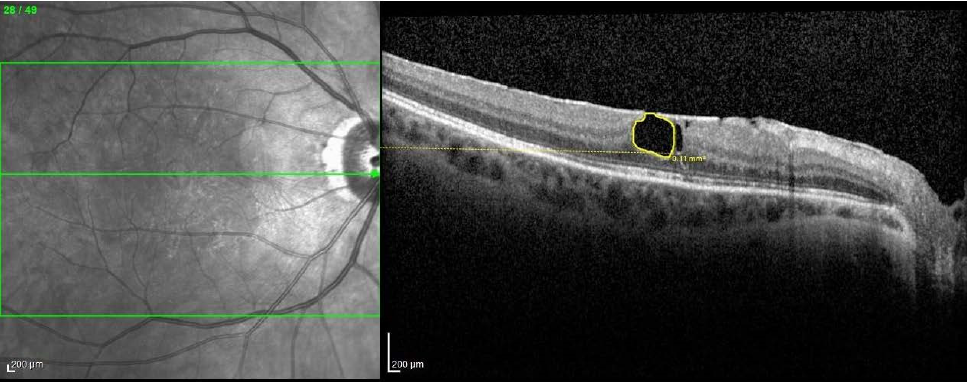
Figure 1. Tissue-loss contouring with automatic gap area calculation in a patient from TL group.